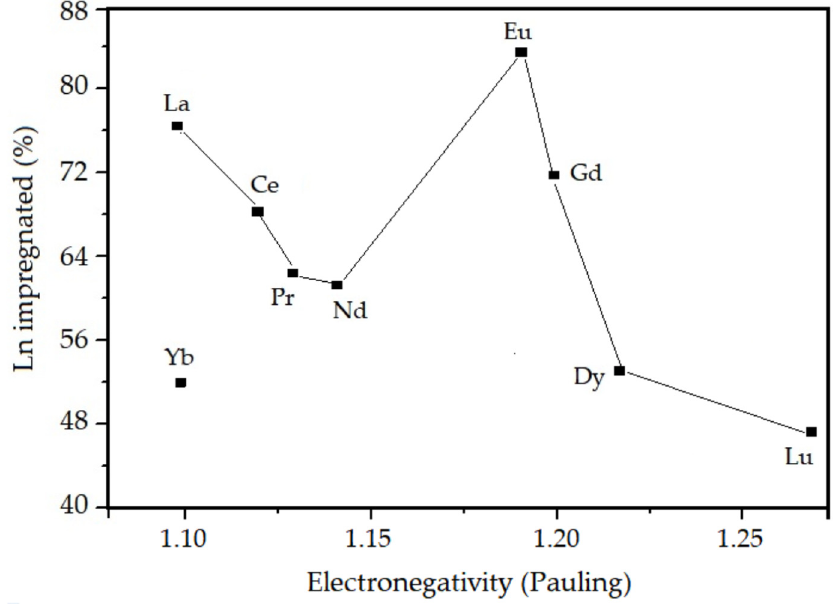
Figure 5. Lanthanide impregnated in the SiO 2 as a function of electronegativity.